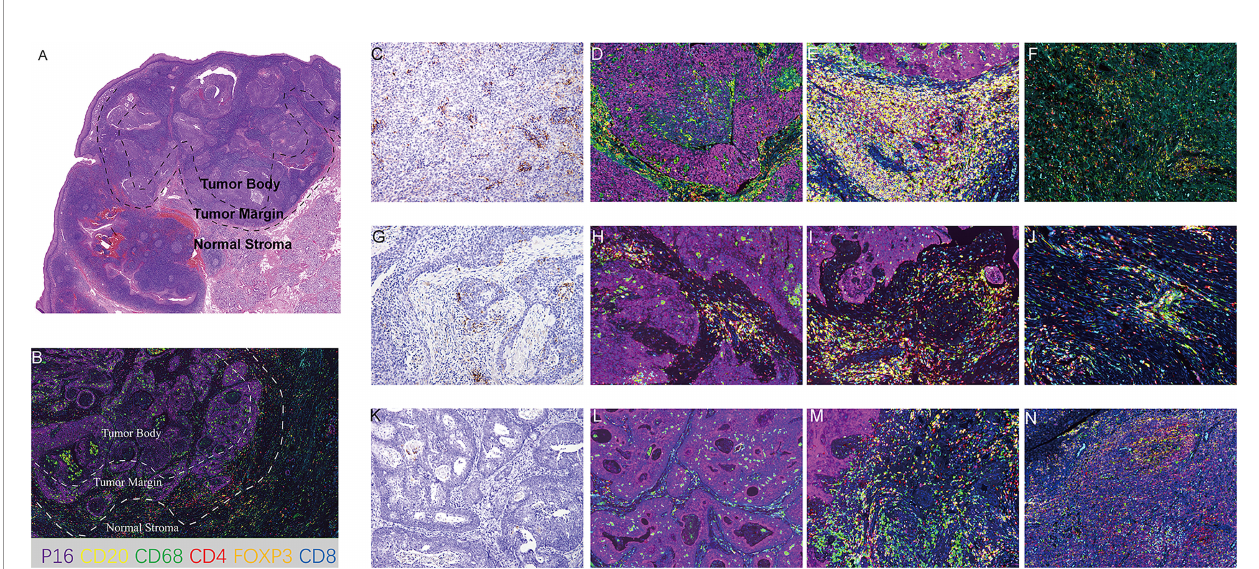
FIGURE 3 | Representative images of mIF. (A) De fi nition of tumor body, tumor margin and normal stromal regions in HE section. (B) De fi nition of tumor body, tumor margin and normal stromal regions in mIF section. (C – F) Representative images of CPS ≥ 20 cases. (C) PD-L1 staining (200X). (D) mIF in TB (200X). (E) mIF in TM (200X). (F) mIF in NS (200X). (G – J) Representative images of 1 ≤ CPS<20 cases. (G) PD-L1 staining (200X). (H) mIF in TB (200X). (I) mIF in TM (200X). (J) mIF in NS (200X). (K – N) . Representative images of CPS<1 cases. (K) PD-L1 staining (200X). (L) mIF in TB (200X). (M) mIF in TM (200X). (N) mIF in NS (200X). CD20, yellow;